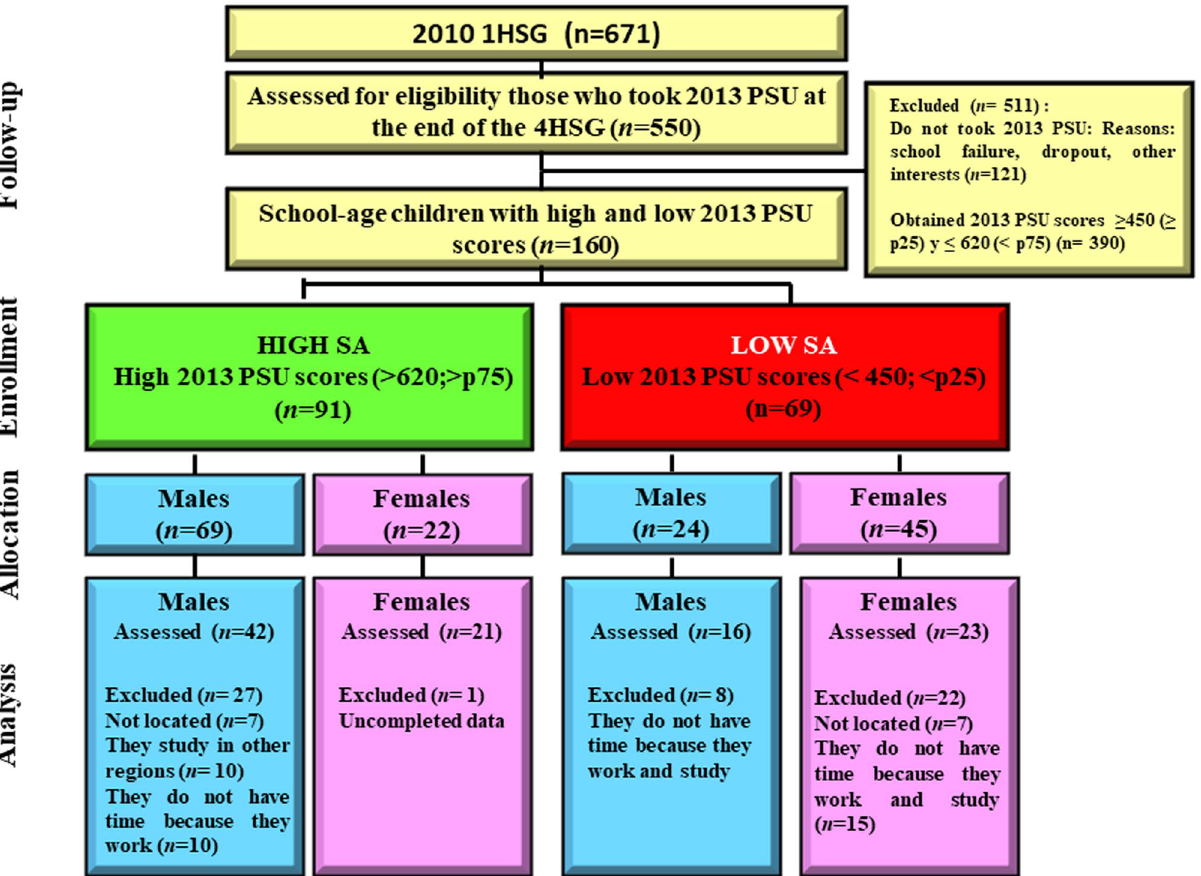
Figure 1. Flow diagram of the sample selection and distribution of the sample by group and sex. PSU: University Selection Test; 1HSG: the first high school grade; 4HSG: the fourth high school grade; SA: scholastic